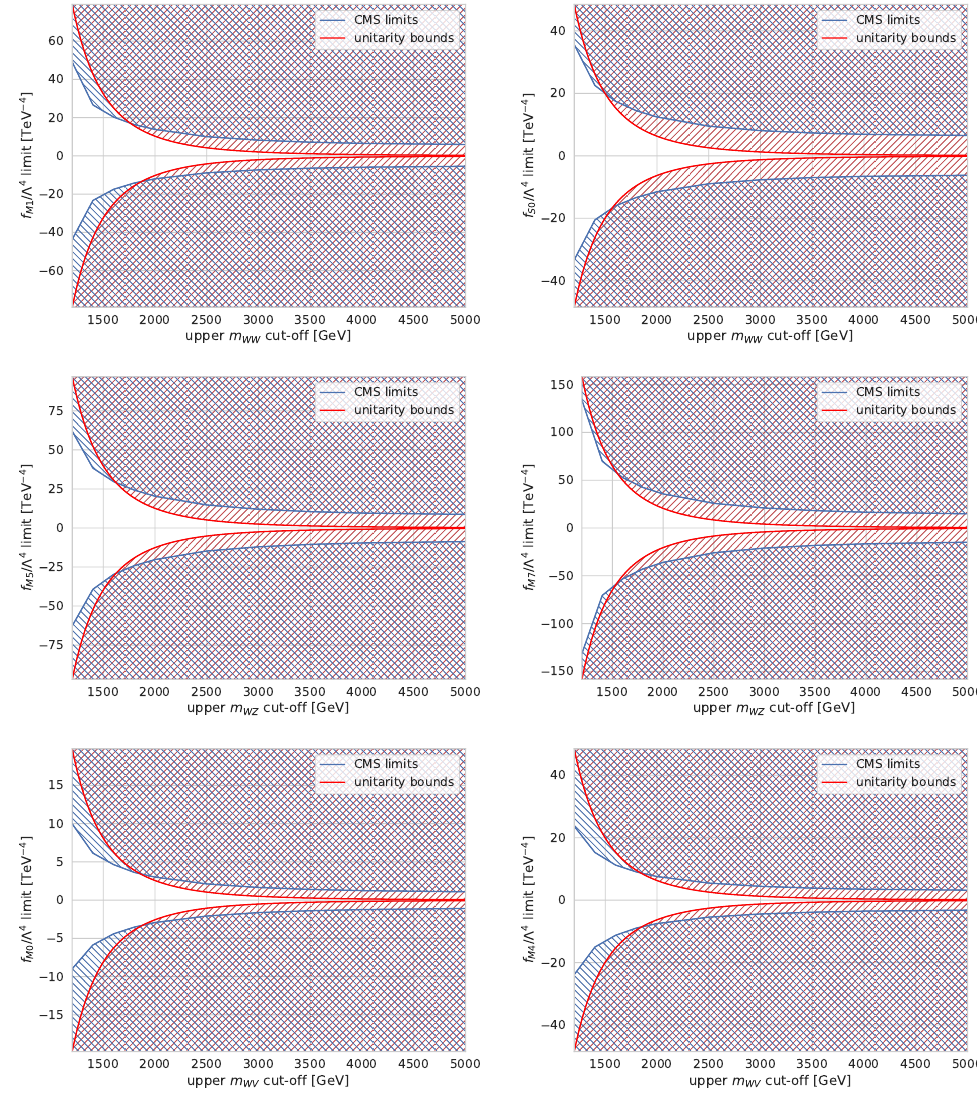
Figure 5 . Estimated limits (blue lines) on the Wilson coefficients for a few processes and operators as a function of the upper invariant mass cut-off m . Superimposed are the unitarity bounds max derived from [24] (red lines). The intersection of the experimental and the unitarity-bound curves represents the best limits which can unambiguously be interpreted in an EFT expansion without violating unitarity. Top row: VBS W ± W ± → 2 ‘ 2 ν process, f (left), f (right). Middle row: M1 S0 VBS W ± Z → 3 ‘ν process, f (left), f (right). Bottom row: VBS W ± V semileptonic process, M5 M7 f M0 (left), f M4